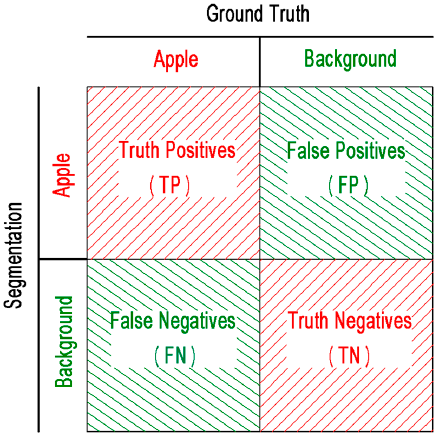
Figure 4. Confusion matrix composed of four cases (TP, FP, FN, and